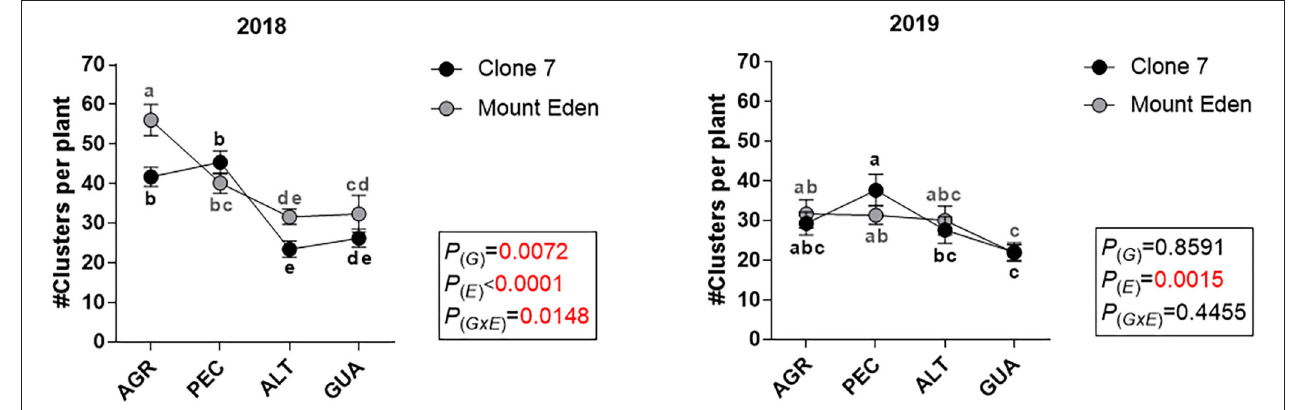
FIGURE 4 | PCA of main anthocyanins in Cabernet Sauvignon Clone 7 (C7) and Mount Eden (ME) wines, from vineyards in AGR, PEC, ALT and